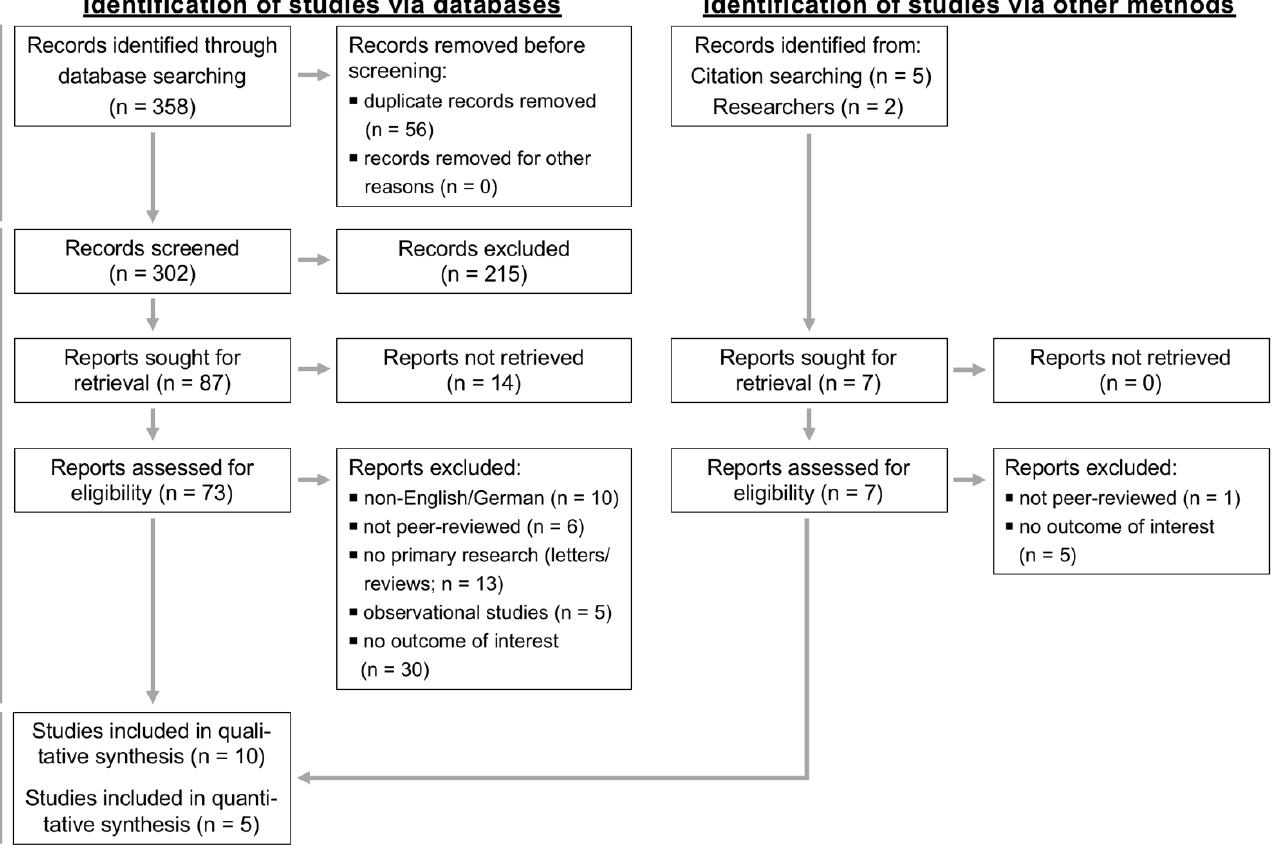
Figure 1. Flow diagram for the systematic review of studies investigating the effect of selective compared to blanket dry cow treatment showing the numbers of studies that were screened, assessed for eligibility, and included in the review and meta-analysis according to the “Preferred Reporting Items for Systematic Reviews and Meta-Analyses” (PRISMA) [23].